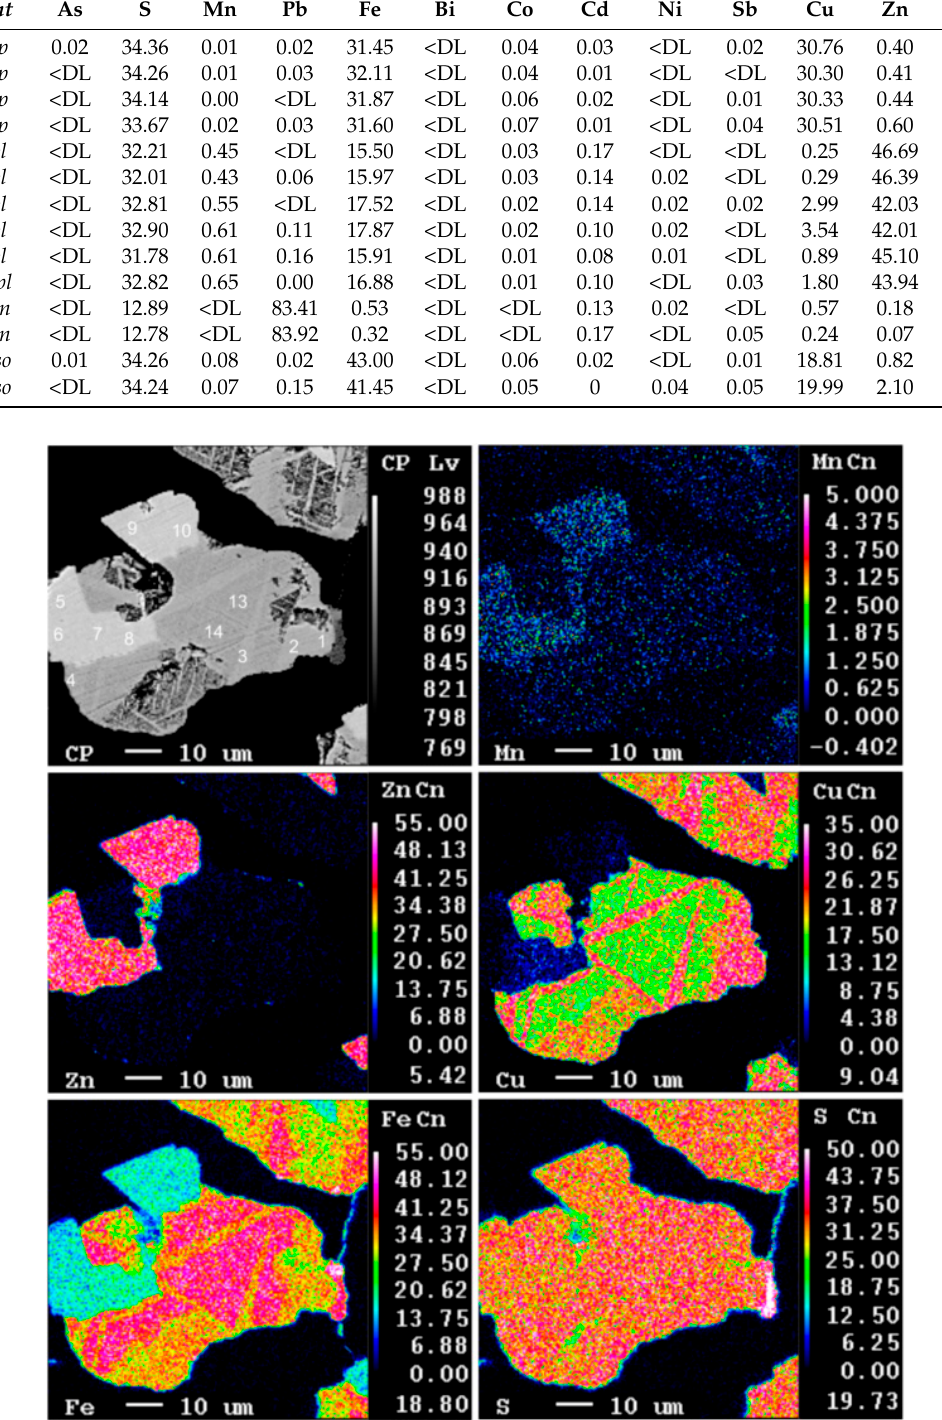
Figure 8. EPMA maps of back scattered electron (BSE), Mn, Zn, Cu, Fe, and S, with colour scales. The featured particle appears in Figure 4d, and the analyses points of Table 4 are marked.